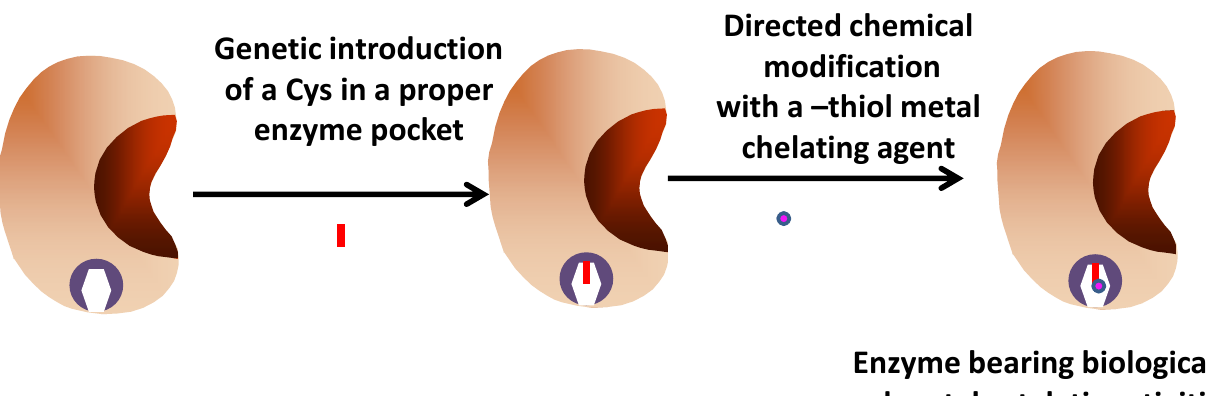
Figure 6. Preparation of enzyme site-directed modified with a metal